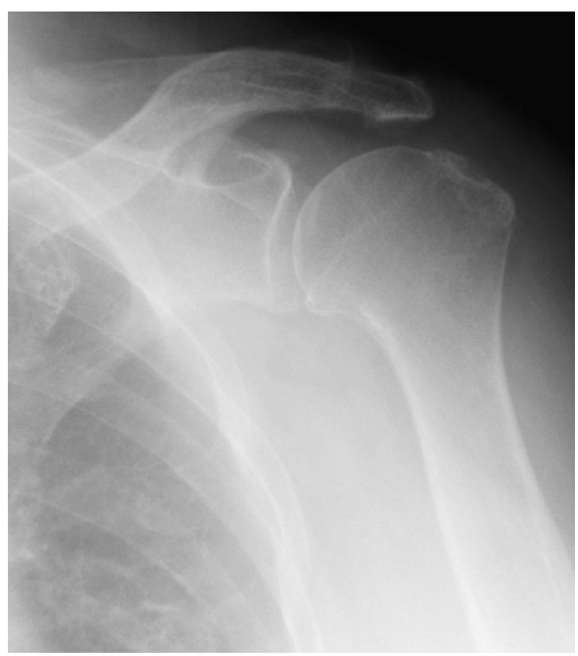
Figure 3. The figure shows the anteroposterior radiograph of Samilson-Prieto grade